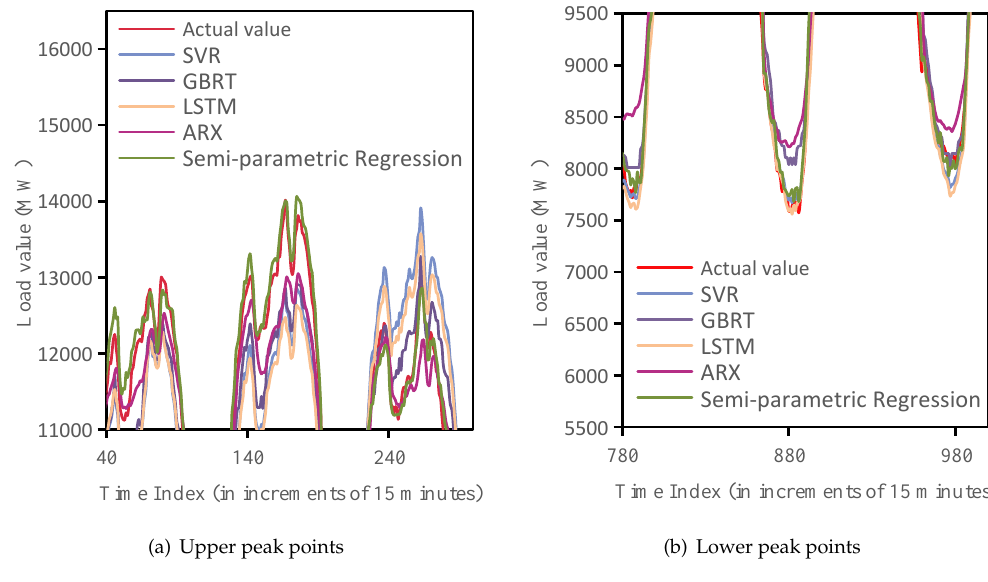
Figure 5. The comparison of forecasting result.